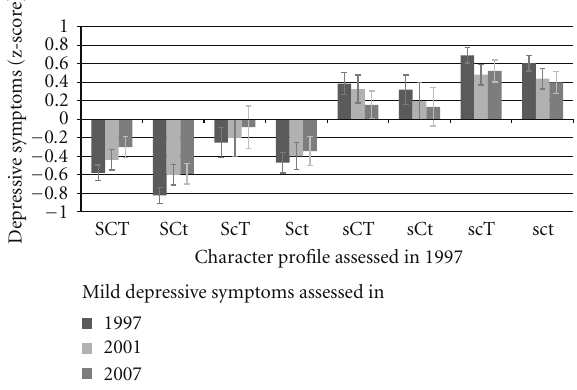
Figure 1: Standardized scores (mean = 0, SD = 1) of mild depressive symptoms (modified BDI) in di ff erent character combinations. 95% confidence intervals included. Sex and birth year were controlled. SCT = creative; SCt = organized; ScT = fanatical; Sct = autocratic; sCT = moody; sCt = dependent; scT = disorganized; sct = depressive.